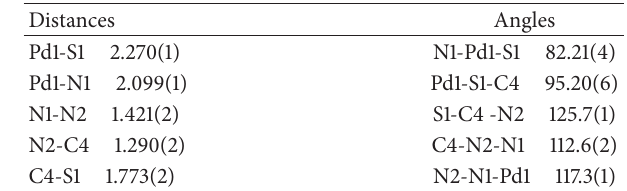
Table 3: Selected bond lengths (˚A) and angles in ( ∘ ) for [Pd(TSC 1 ) ( 6